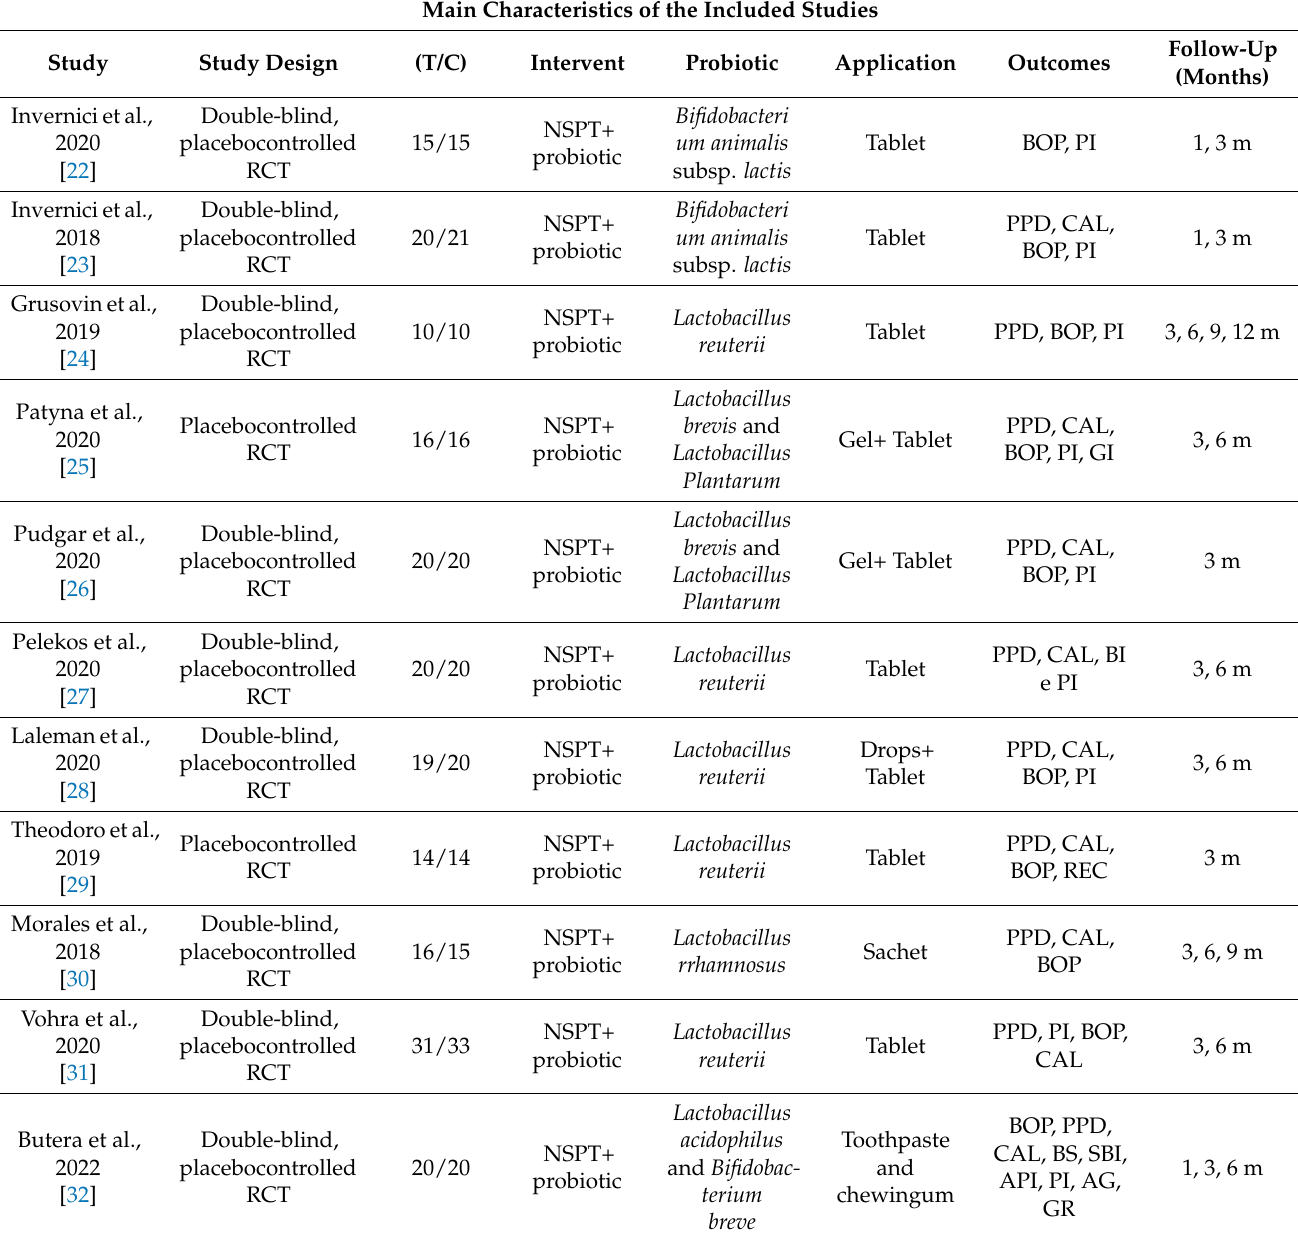
Table 1. Main characteristics of the included